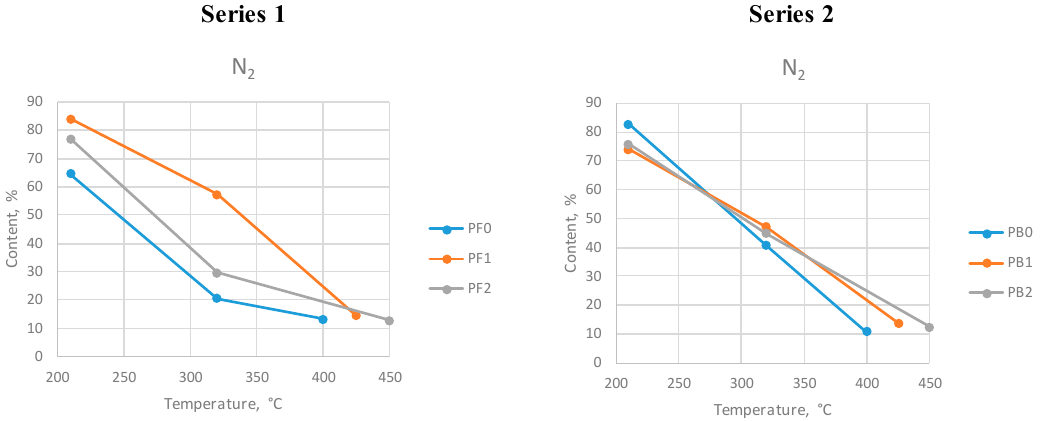
Figure 6. Nitrogen content at different max. temperatures during series 1 and 2.